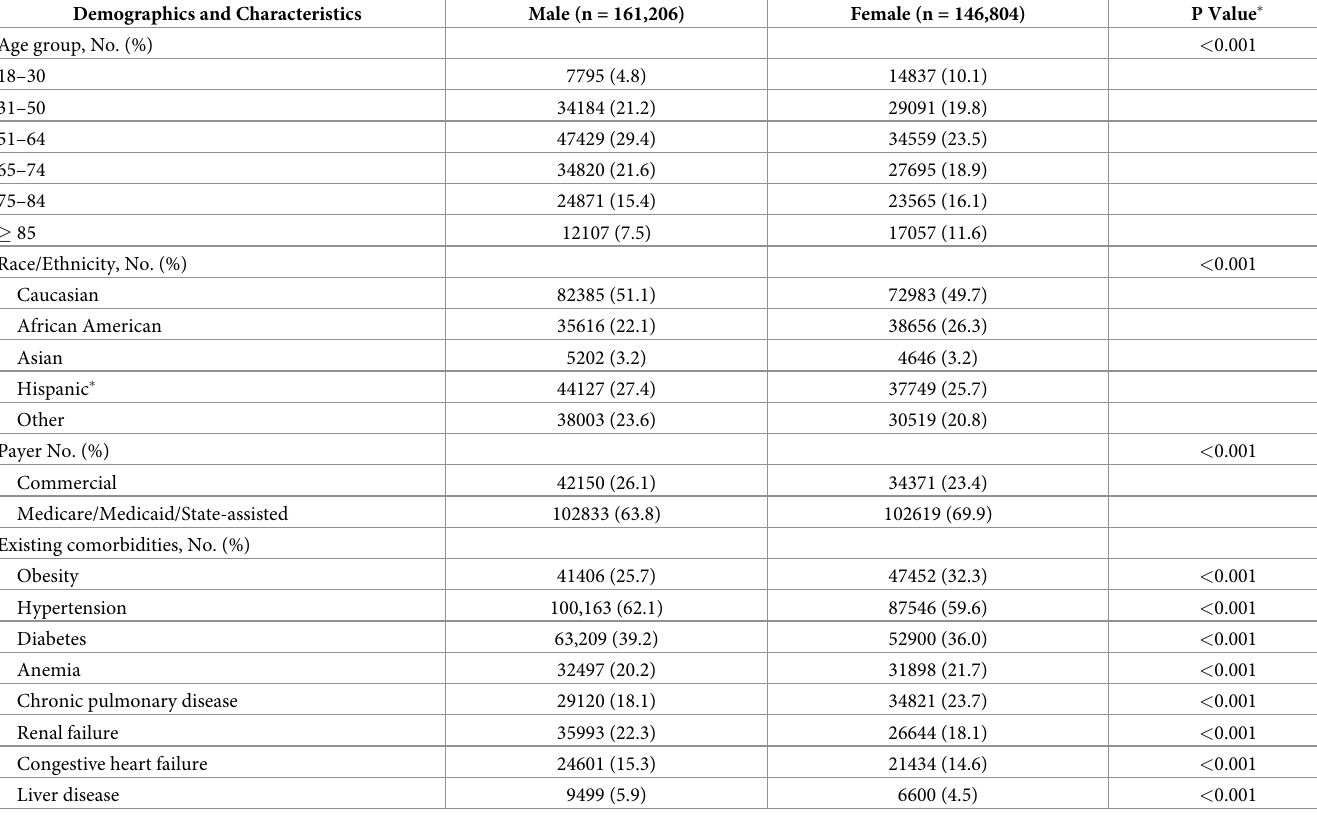
Table 1. Summary of demographics and characteristics of male vs female adults with